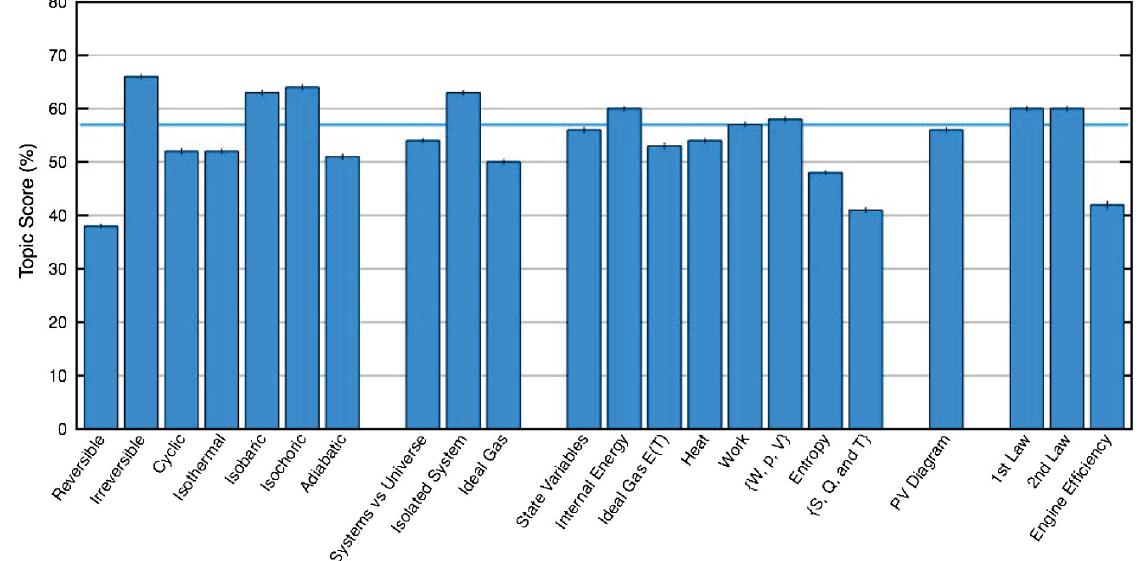
instrument.FIG. 5. Average performance on the STPFaSL instrument by topic for N ¼ 147 upper-level undergraduates and Ph.D. students. For completeness, error bars on each topic score (very small black vertical lines) indicate the sample error of the mean topic score, assuming each topic is independent . For comparing pairs of topics whose coverage on the STPFaSL instrument is minimally overlapping, e.g., comparison of performance on questions involving Irreversible and Reversible processes, an assumption of independence may be appropriate, but otherwise the topics and their errors should not be directly compared within a population. Another pair of topics for which there is minimal overlap involves the second law problems and problems requiring knowledge of the state variables. The blue horizontal line shows the average on the entire